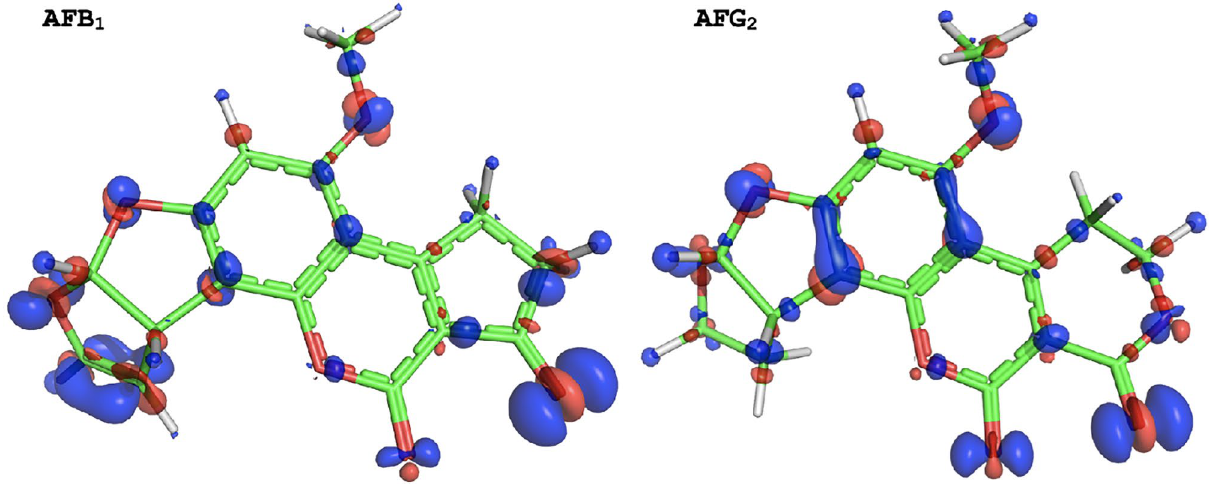
Figure 2. Isosurfaces of the Fukui functions of AFB 1 and AFG 2 in the gas phase indicate the sites prone to oxidation. Fukui isosurfaces: red (−) and blue (+). Isosurface level of ± 0.003 Å −3 .